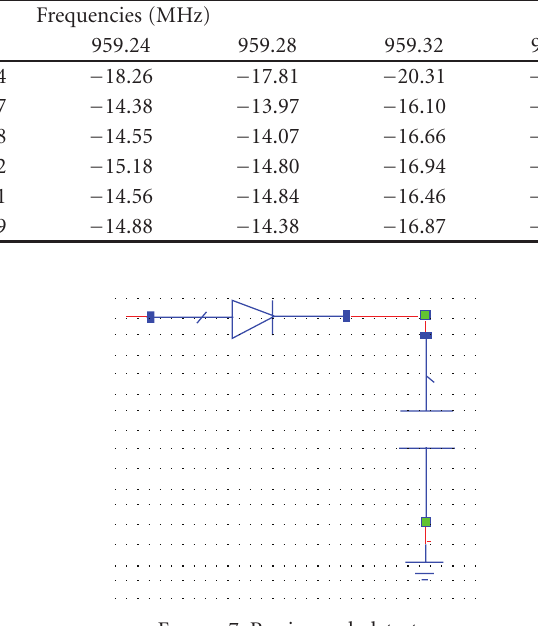
Figure 5: GSM embedded antenna.